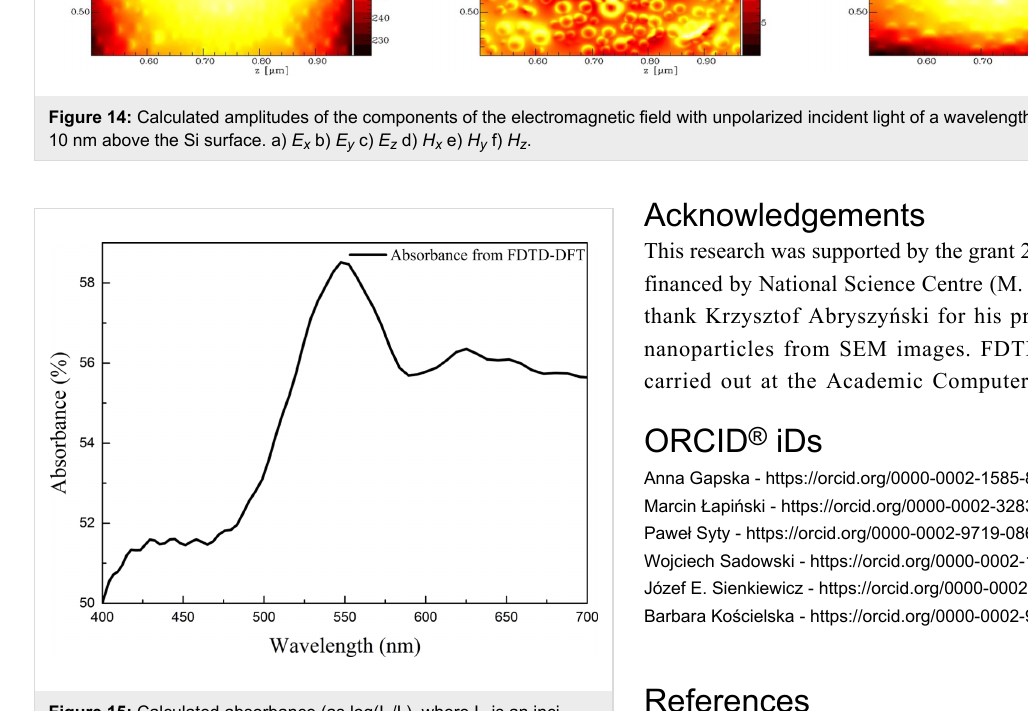
Figure 15: Calculated absorbance (as log(I o /I r ), where I o is an inci- dent flux, and I r – reflected flux), as the function of the incident light